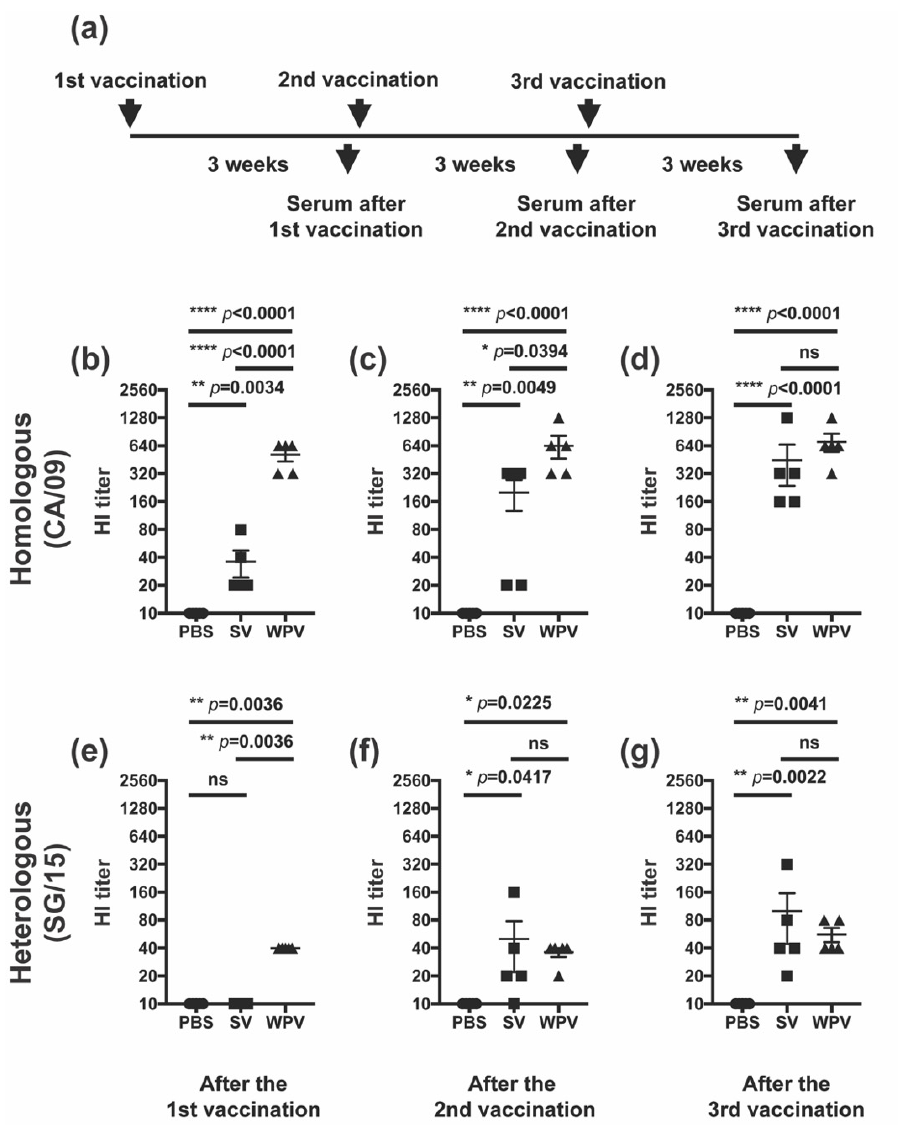
Figure 2. HI antibody titers after vaccination with WPV or SV. ( a ) Schematic representation of the experimental schedule. C57BL/6 mice were subcutaneously vaccinated three times at 3-week intervals with 9 µg of protein of monovalent CA/09 WPV or SV. HI antibody titers against homologous CA/09 ( b – d ) and heterologous SG/15 ( e – g ) were evaluated in serum samples collected on days 19 ( b , e ), 41 ( c , f ), and 52 ( d , g ). Dots represent individual values, and the mean values with SEM are indicated by lines ( n = 5 per group). The circles, squares, and triangles indicate data from mice inoc- ulated with PBS, SV, and WPV, respectively. * p < 0.05, ** p < 0.01, **** p < 0.0001, one-way ANOVA using a multiple-comparison correction; ns indicates not significant ( p > 0.05).3.2. After Multiple Vaccinations, Mice Inoculated with SV Induced HI Antibodies Comparable to Those of Mice Vac- cinated with WPV. 3.3. WPV Induced Better NI Antibodies than SV In addition to anti-HA antibodies, we further evaluated WPV and SV for the induc- tion of antibodies against NA, the second major surface glycoprotein of influenza viruses. Serum samples collected from mice vaccinated with either WPV or SV as described above were subjected to the NI assay. NI antibody titers against homologous CA/09 in the WPV- vaccinated group were significantly increased even after the first vaccination, and the val- ues were further elevated by additional vaccinations (Figure 3a–c). On the other hand, NI antibody titers against CA/09 in SV-vaccinated mice ranged from undetectable to very low